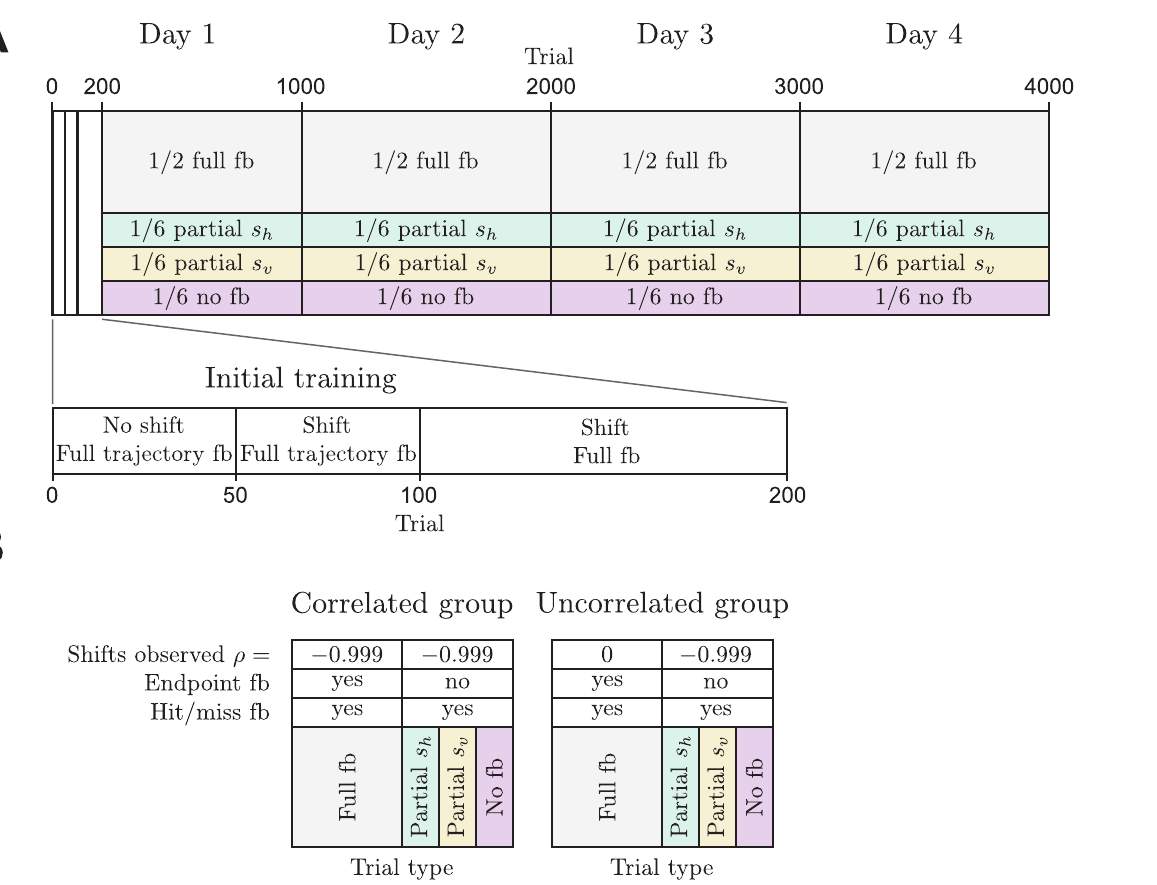
Fig 2. Schematic of the experimental design. A Participants were recorded over four sessions spread across four days. The first session included an additional training phase (first 200 trials) to allow participants to get used to the experimental setup. After this initial training phase, the different trial types were presented randomly according to the specified proportions. B Experimental conditions for the correlated and uncorrelated